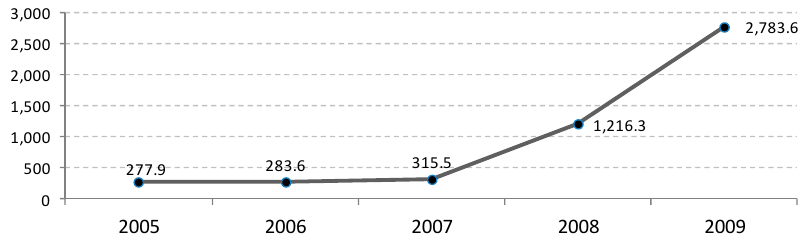
Figure 8. Trend of PV sector contribution to Spanish gross domestic product (GDP) in millions of real euros (basis 2010), for the period 2005–2009 [52] .